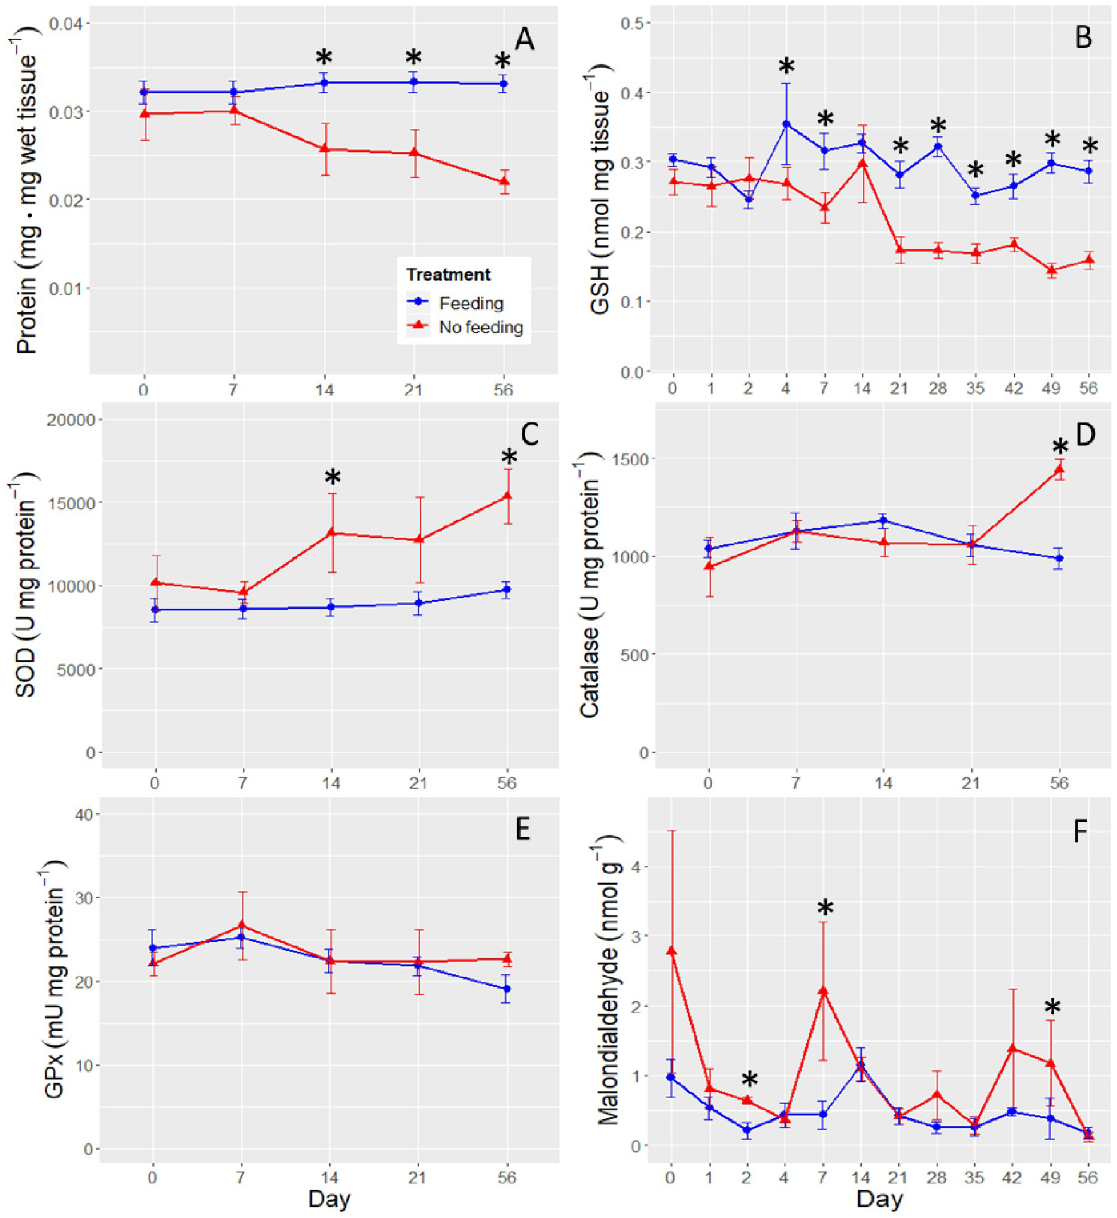
Fig 6. Biomarkers of oxidative stress in liver. Panel A is liver protein concentration, panel B is Glutathione, panel C is superoxide dismutase, panel D is catalase, panel E is glutathione peroxidase, and panel F is malondialdehyde. The stars denote the time points at which significant differences were detected between the two treatments. The x-axis is not to scale and the error bars are ±